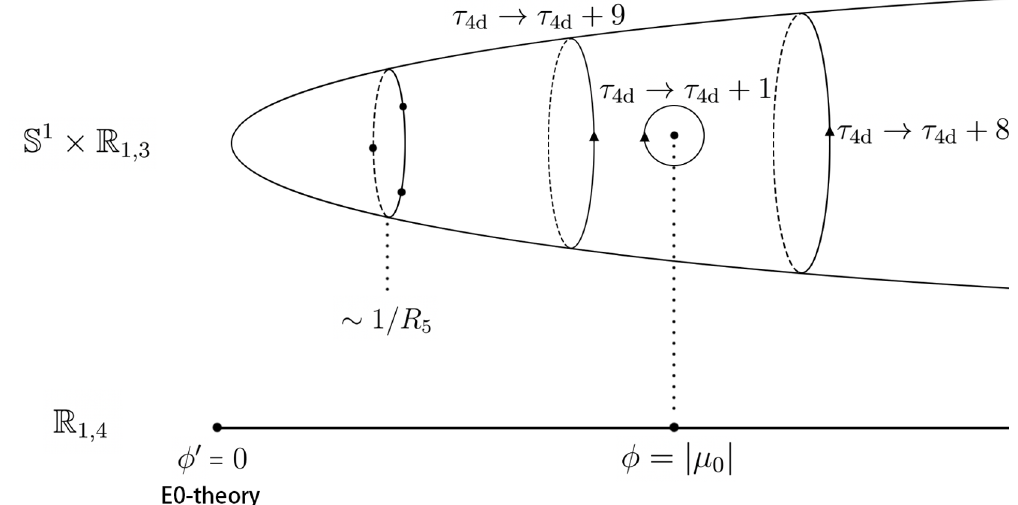
Figure 21 . Moduli space for F1-theory with negative